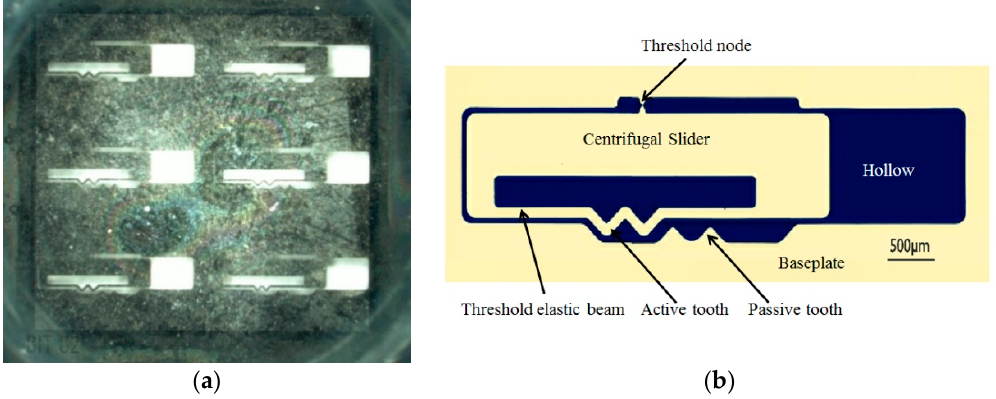
Figure 12. The micro-sample of the elastic-beam delaying mechanism ( a ) overall view, ( b ) partial view.